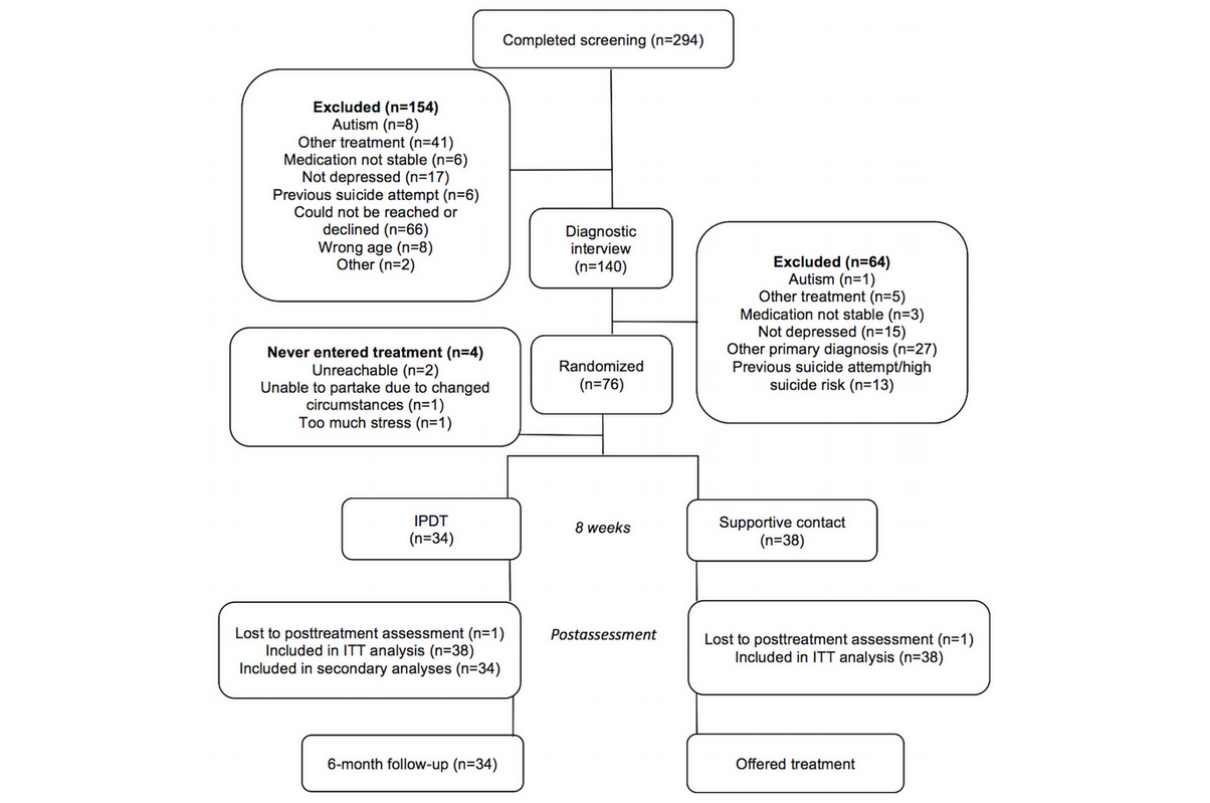
Figure 1. CONSORT (Consolidated Standards of Reporting Trials) flowchart. IPDT: internet-based psychodynamic therapy; ITT: